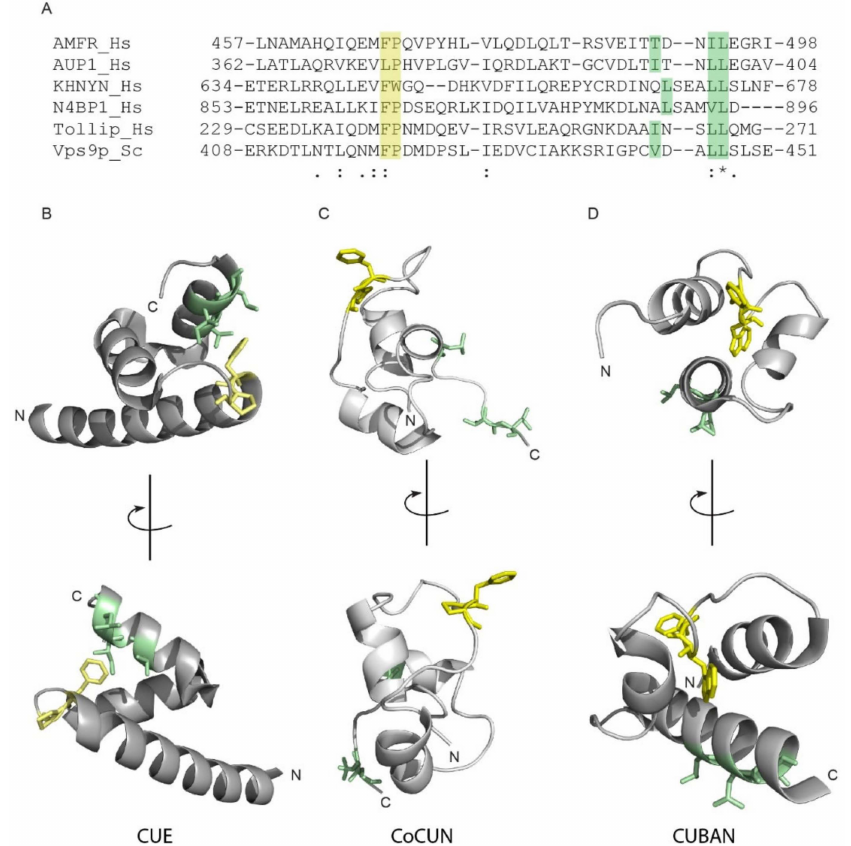
Figure 8. ( A ) Multiple sequence alignment between KHNYN, N4BP1, and members of the CUE domain protein family. Amino acid ranges: hAMFR (aa 457–498), hAUP1 (aa 362–404), hKHNYN (aa 634–678), hN4BP1 (aa 853–896), hTOLLIP (aa 229–271), and ScVps9p (aa 408–451). The FP / FW and the di-leucine motifs are highlighted in grey boxes. Consensus symbols in the alignment: ‘.’ indicates conservation between groups of weakly similar properties; ‘:’ indicates conservation between groups of strongly similar properties; ‘*’ indicates positions which have a single, fully conserved residue. Coloured boxes show the FP pair (yellow) and the ϕ xx(I / L / V)L motif (brown). ( B – D ) Cartoon representations of the CUE domain of AMFR (B, PdB 2EJS), the UBD of N4BP1 ( C ) and the CUBAN domain of KHNYN ( D , PdB 2N7K). The FP / FW and the C-terminal hydrophobic motifs of N4BP1, AMFR, and KHNYN are shown in sticks colored as in ( A